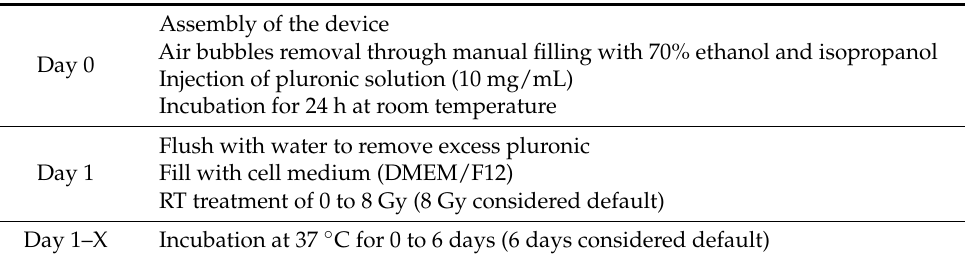
Table 1. Device preparation and experimental